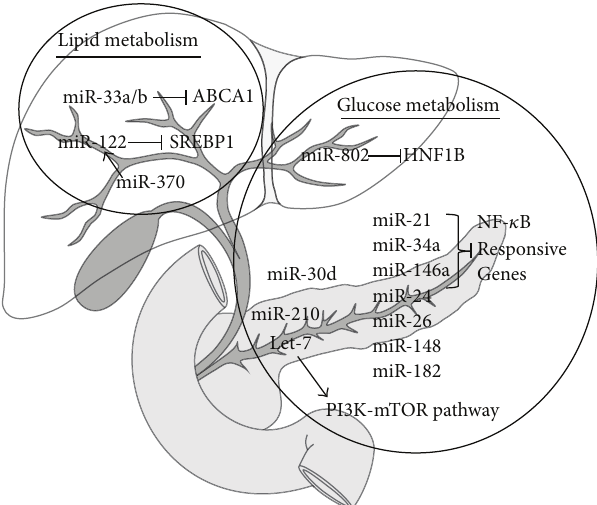
Figure 2: miRNAs involved in glucose and lipid homeostasis. ABCA1: a subfamily ATP-binding cassette 1; SREBP1: sterol regu- latory element-binding protein 1; HNF1B: hepatocyte nuclear factor 1 𝛽 ; NF- 𝜅 B: nuclear factor kappa B; PI3K-mTOR: phosphoinositide